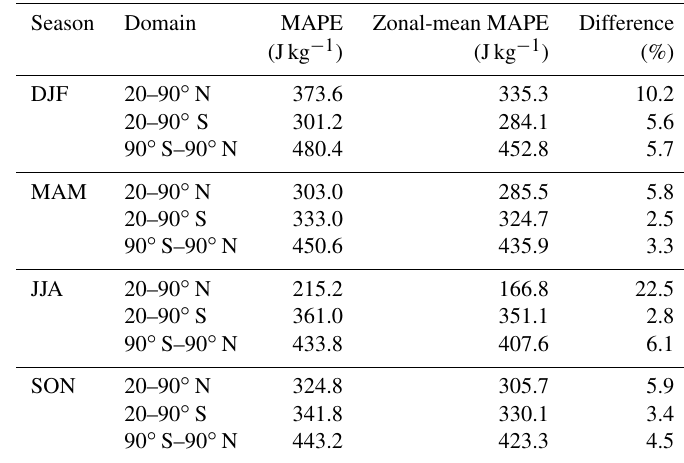
Table 1. Extratropical and global MAPE values in joules per kilogram based on the time mean over 1979–2018 for different seasons. Results are given for three-dimensional MAPE, zonal-mean MAPE, and their difference. Zonal-mean MAPE is calculated by replacing all values for temperature and humidity at a given latitude and pressure with the zonal-mean values at that latitude and pressure. The difference is calculated as the three-dimensional MAPE minus zonal-mean MAPE as a percentage of the three-dimensional MAPE. All results in this table are calculated with integer linear programming. DJF: December–January–February, MAM: March–April–May, JJA: June–July–August, SON: September–October–November.